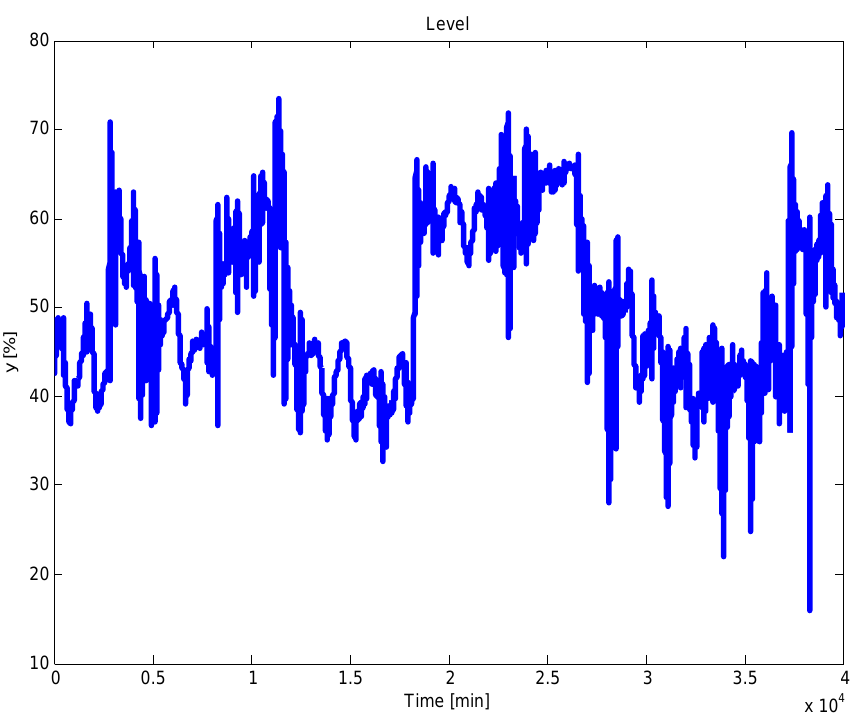
Figure 7. Level experimental data of heat exchanger HX4 for a month